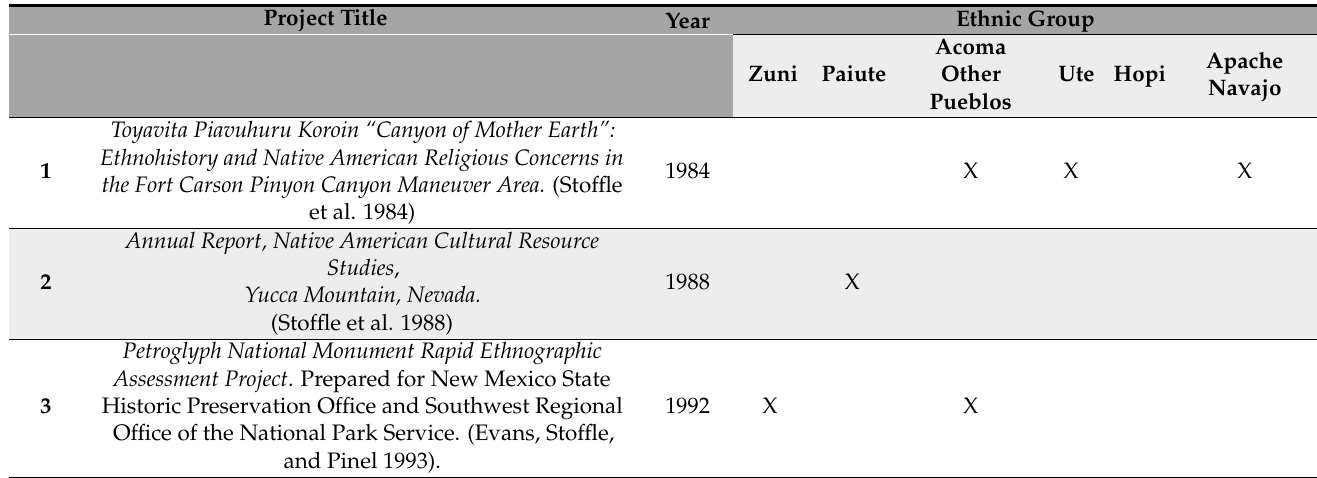
Table A1. Ethnographic studies involving volcanoes conducted with Sunset-Wupatki